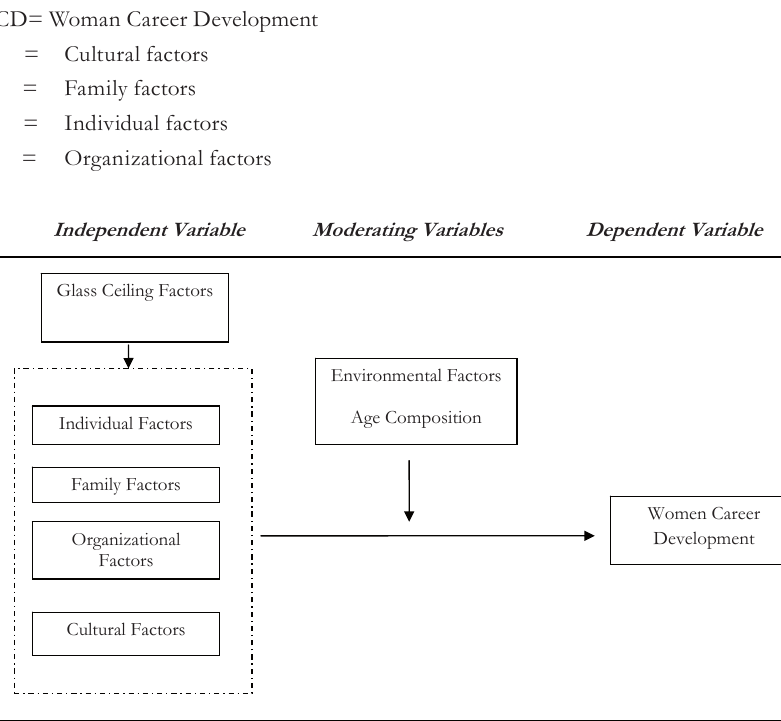
Fig. 1 - Conceptual framework. Source: developed by researcher.